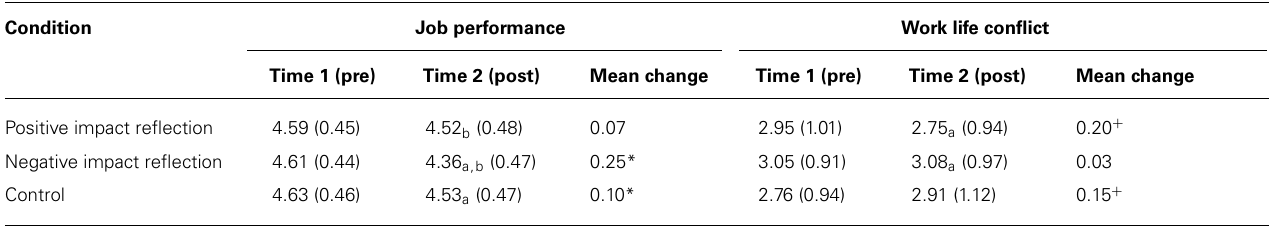
Table 2 | Means, SD, and mean changes by intervention